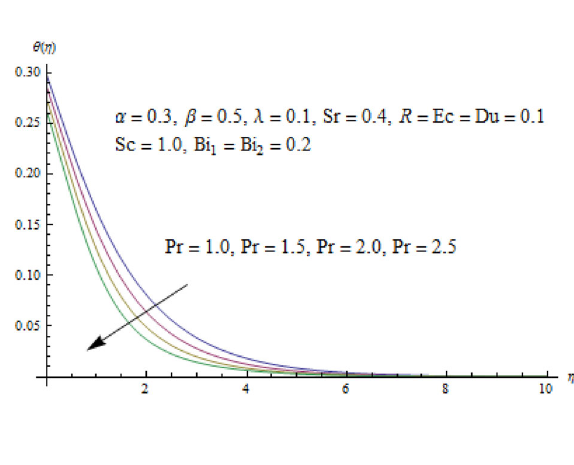
Fig. 21 Impact of Pr on